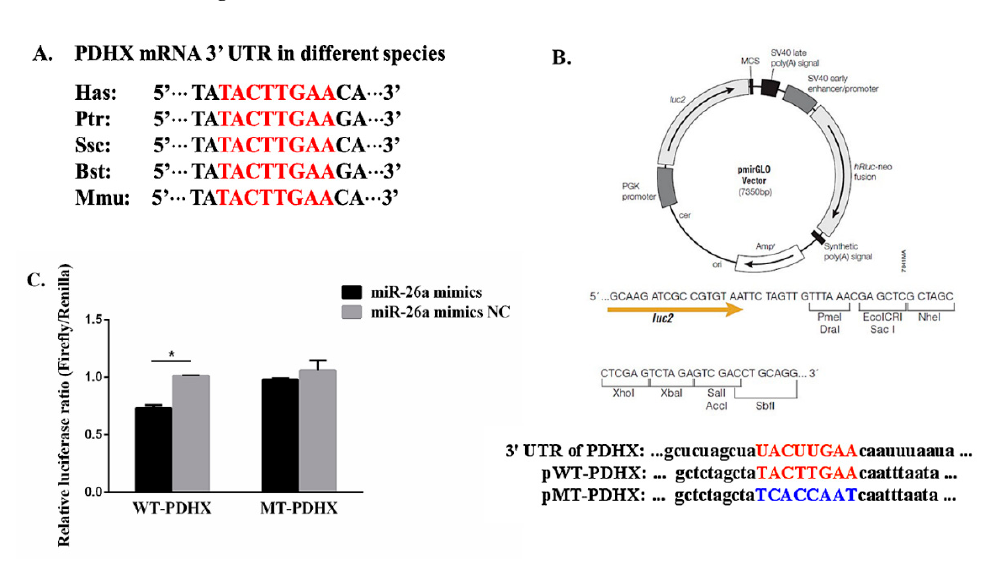
Figure 1. Target gene prediction of miR-26a and dual-luciferase reporter assay. ( A ) The predicted binding sites between pyruvate dehydrogenase complex component X ( PDHX ) 3’-UTR and miR-26a in various species. ( B ) The structure of recombinant plasmid and the binding site of wild type (WT) (red colored) and mutant type (MT) (blue colored) between PDHX 3’-UTR and miR-26a. Firefly luciferase and Renilla luciferase were regarded as the report gene and reference gene, respectively. ( C ) The result of dual-luciferase reporter assay. “*” indicates statistical significance at P < 0.05.